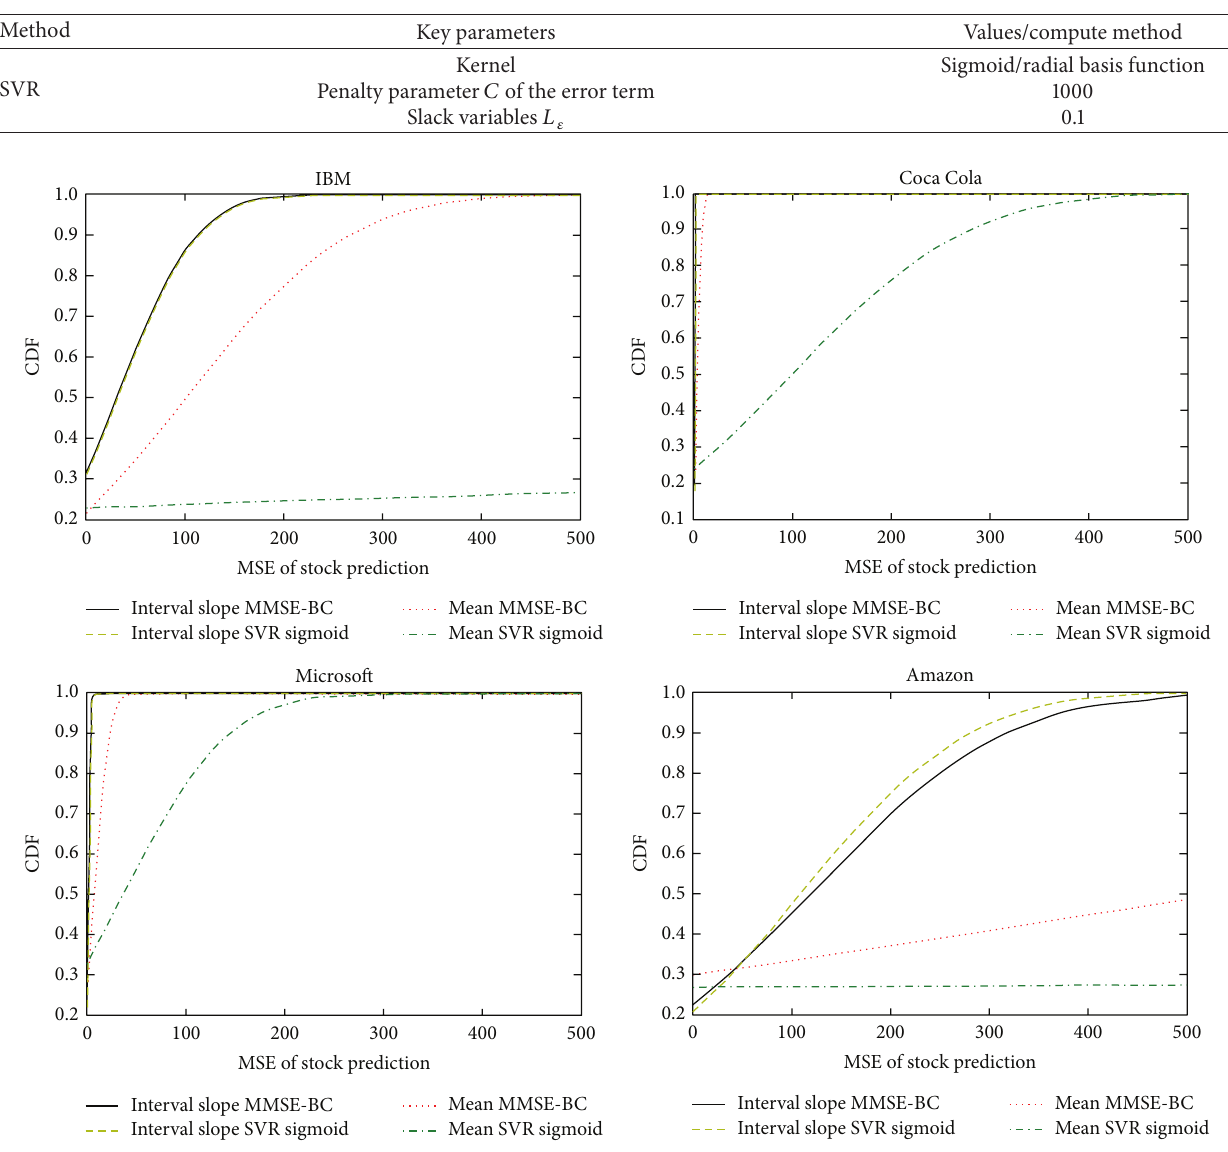
Table 1: Optimized parameters for the method.